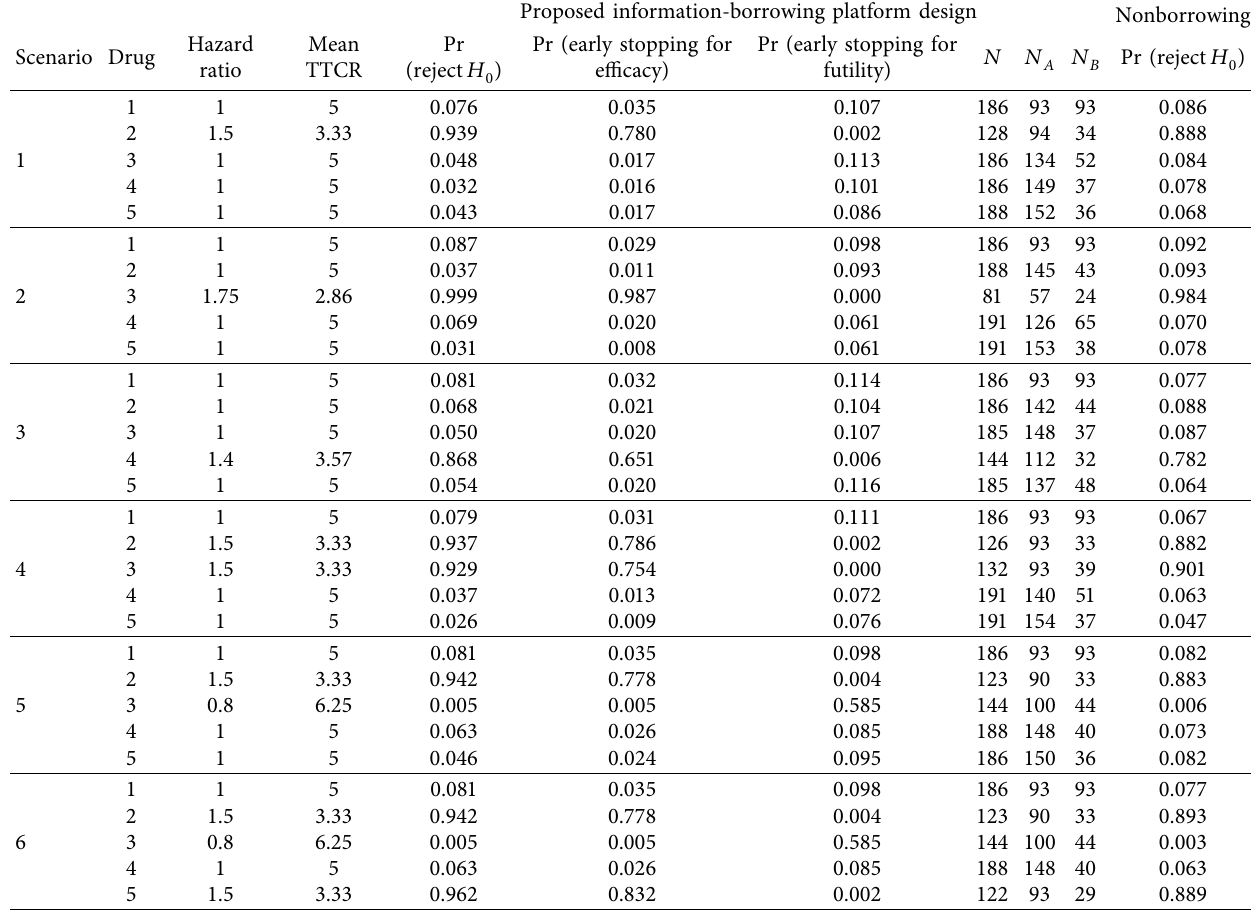
Table 1: Operating characteristics of proposed platform design with comprehensive screening